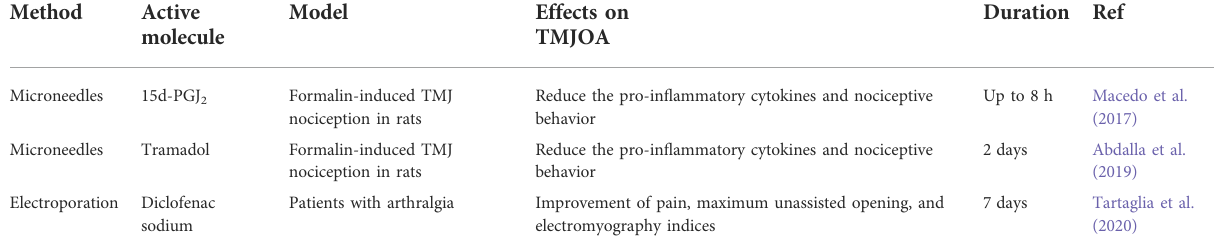
TABLE 2 Different transdermal drug delivery systems for